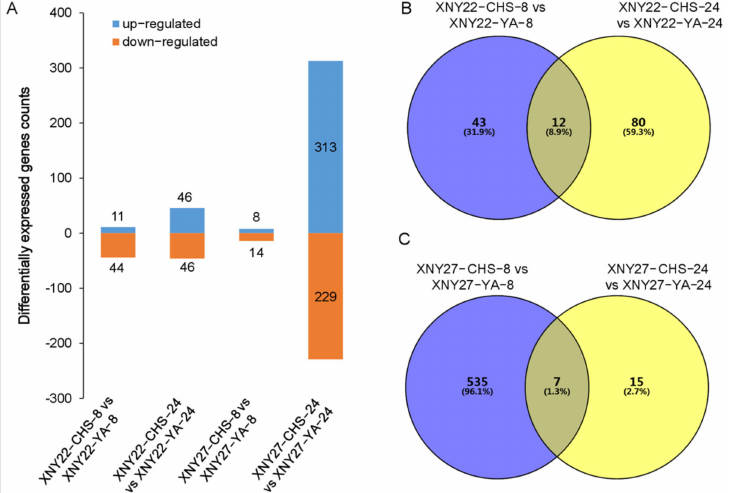
Figure 2. The differentially expressed genes analysis. ( A ) The number of DEGs in four groups. ( B ) Venn diagram of hybrid maize XNY22 DEGs in two groups. ( C ) Venn diagram of hybrid maize XNY27 DEGs in two